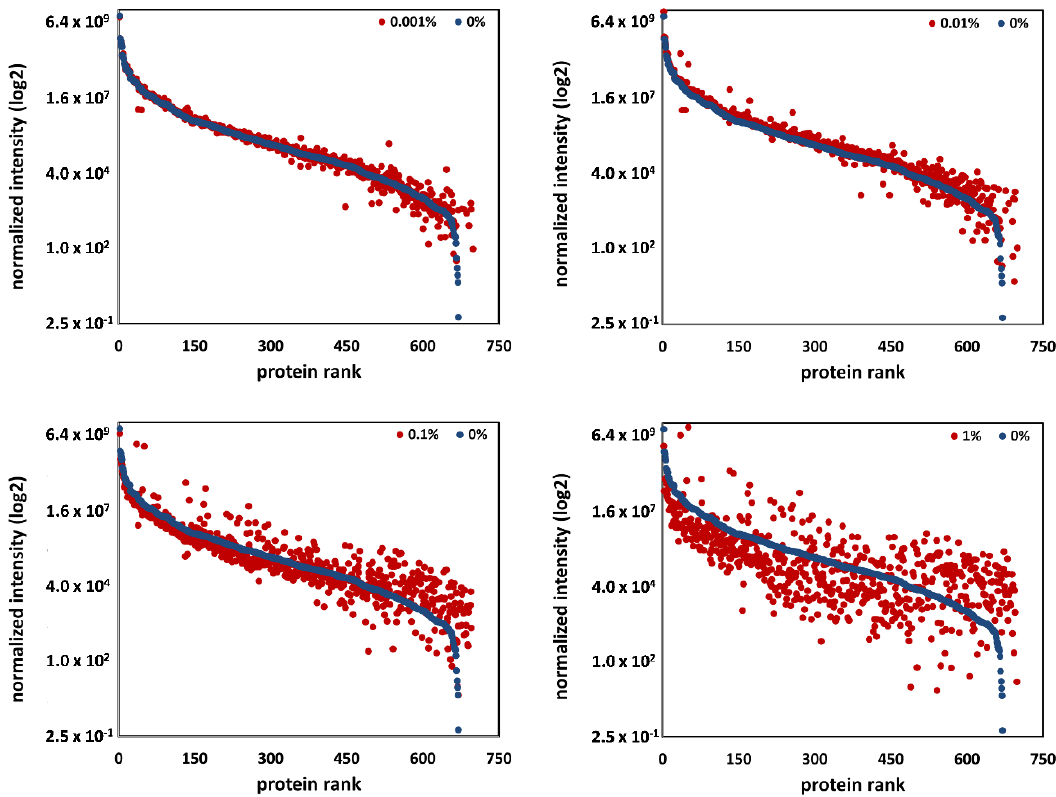
Figure 6. Quantitative impact of blood contamination on the global proteome. The normalized intensity values (obtained from the data analysis with the MS software Progenesis QI for CSF 1) of each protein in the reference sample (blue dots) were plotted in comparison to corresponding spike-in samples (red dots) including blood levels of 0.001%, 0.01%, 0.1%, and 1%. Decreases in the relative protein abundance were observed for samples starting with blood levels of 0.1% and 1%, while the number and abundance of non-specific CSF proteins increased.